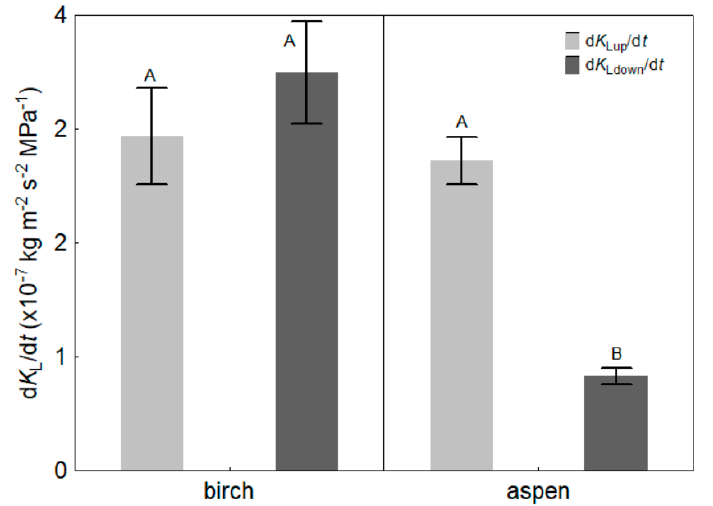
Figure 5. Mean values ( ± SE) of the rates of up- (d K Lup /d t ) and down-regulation of K L (d K Ldown /d t ) of silver birch ( Betula pendula ) and hybrid aspen ( Populus × wettsteinii ). Different letters express statistically significant ( p < 0.01) differences between the means.